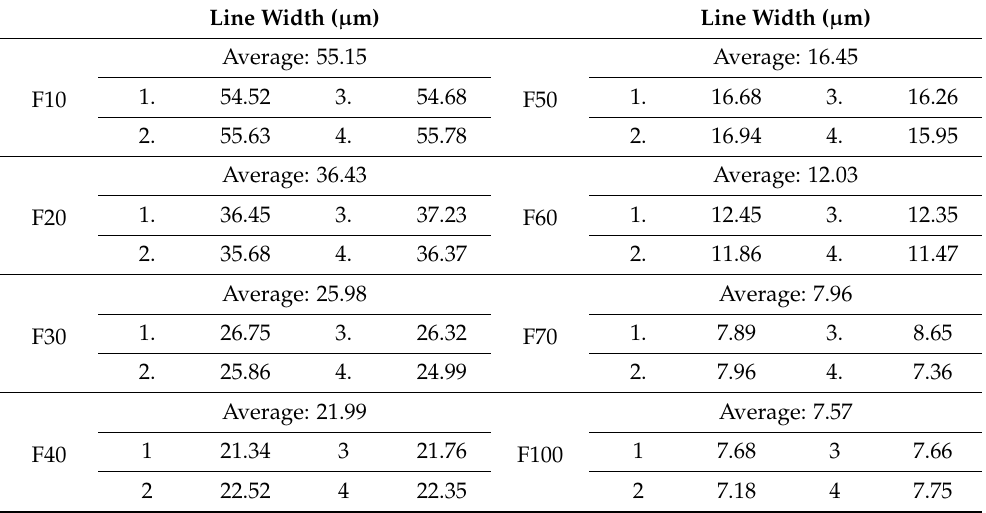
Table 2. The measurement data of depositing